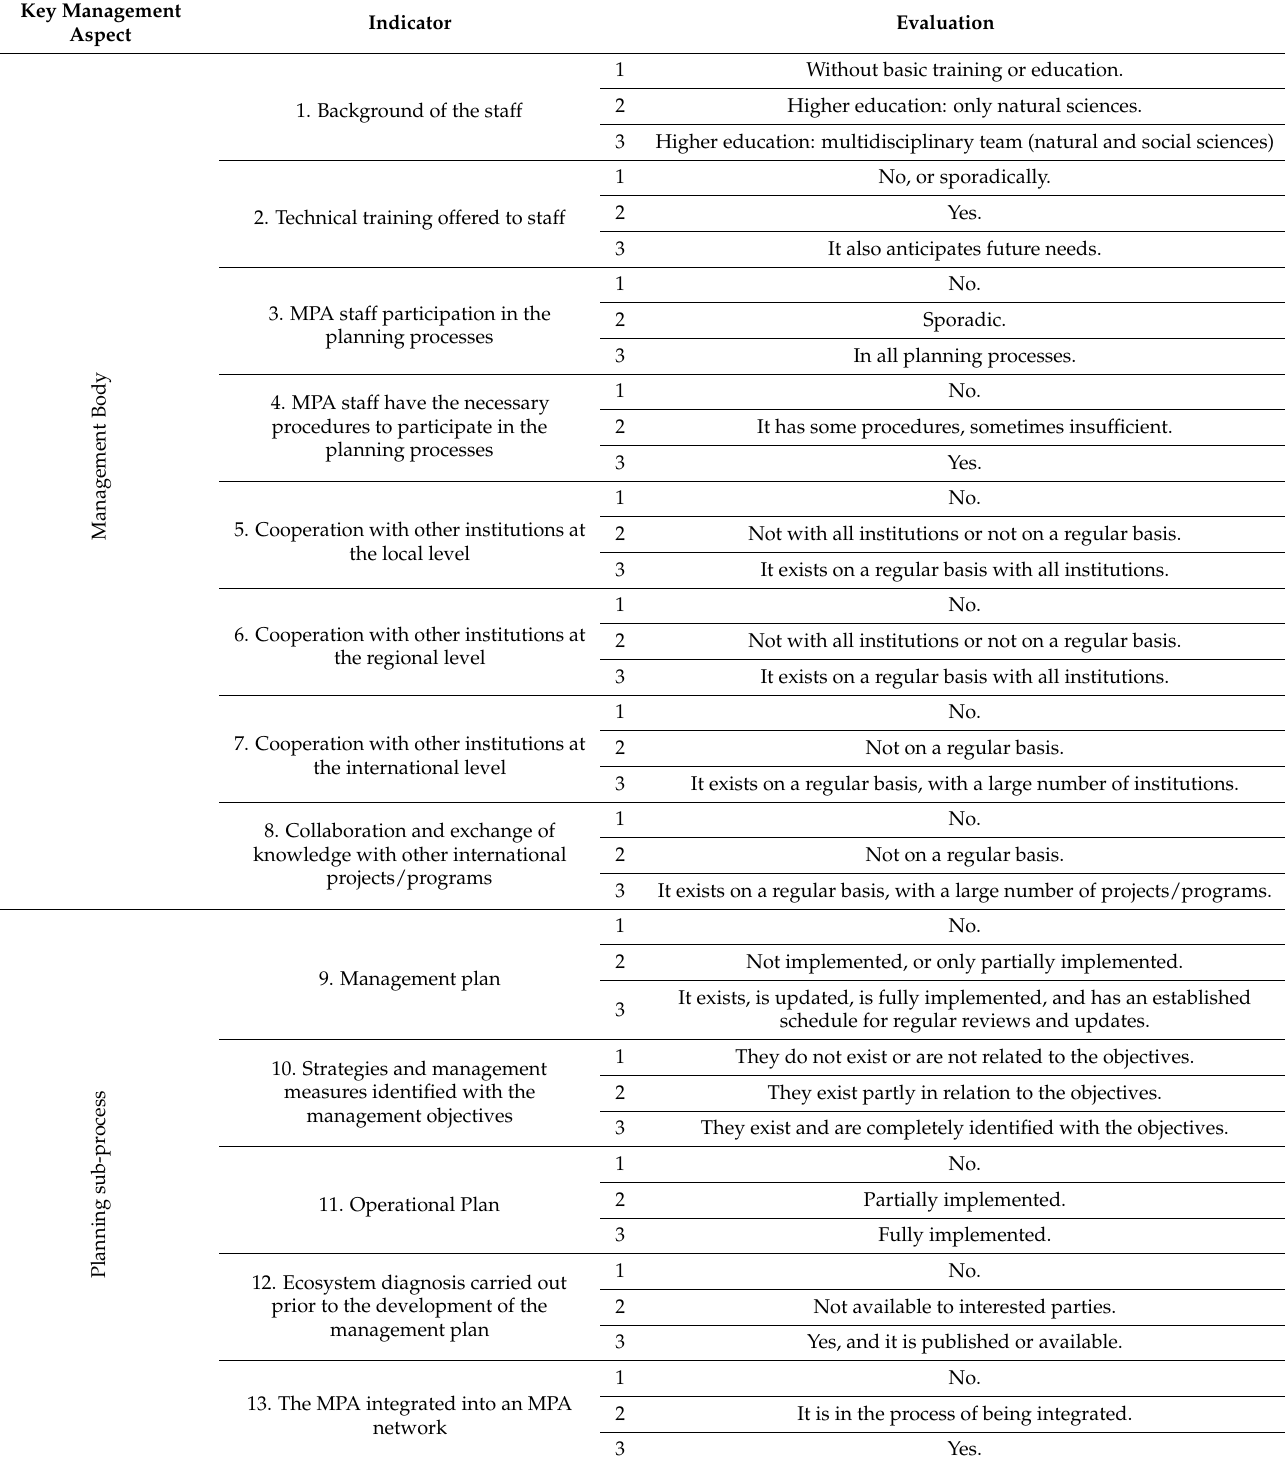
Table 1. Indicators for MPA management